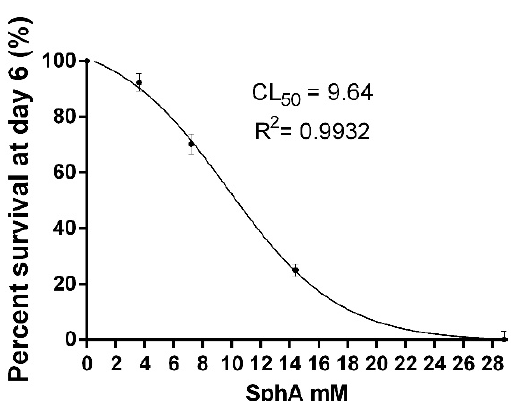
Figure 4. The dose-dependent survival rate of aphids exposed to sphaeropsidin A. Values are reported as mean ± standard deviation (SD) of three replicates in four separate experiments and expressed as a percentage of the control